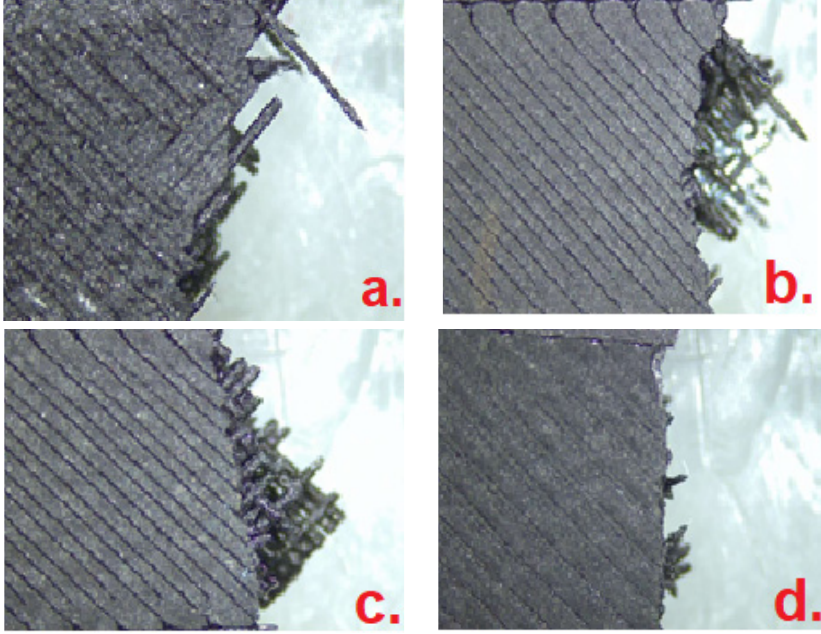
Figure 12. Macroscopic observation after quasi-static tensile test: ( a ) hexagonal, ( b ) triangular, ( c ) rectangular, and ( d ) solid fill.